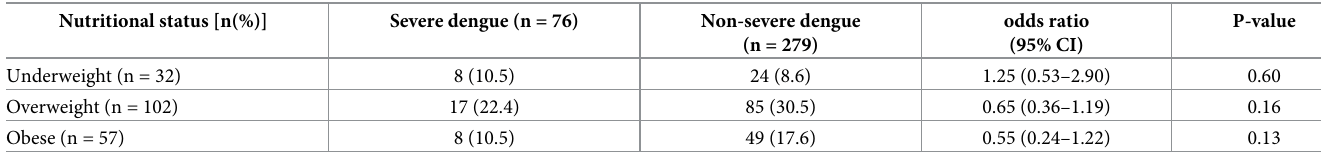
Table 5. Association between nutritional status and dengue severity according to the 2009 WHO